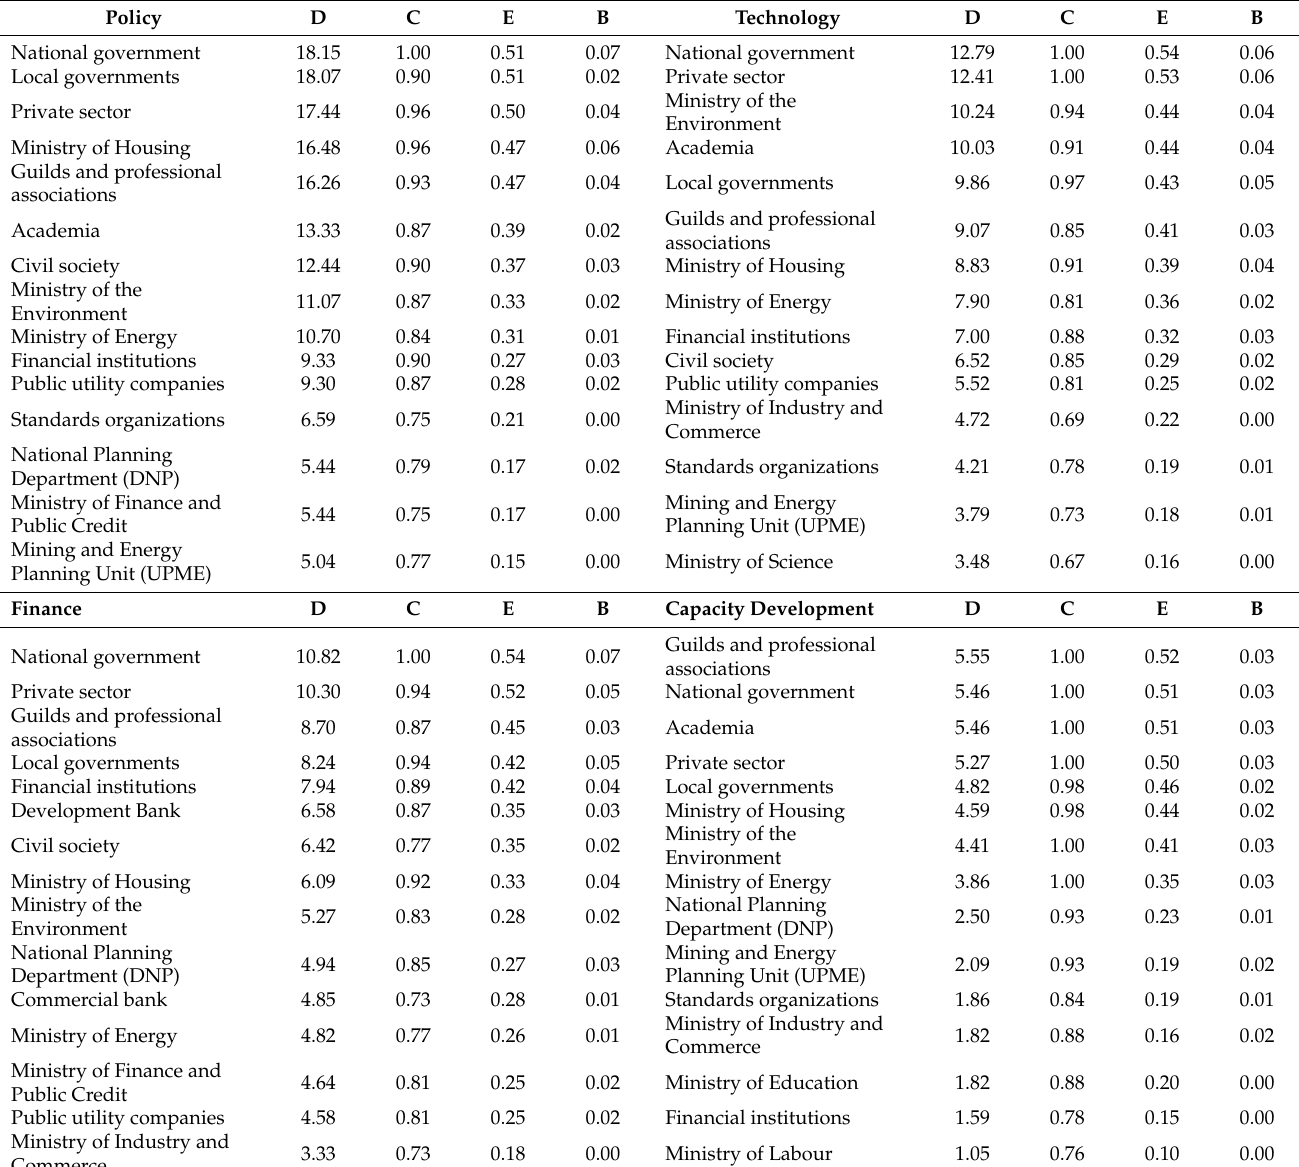
Table 7. Network-based metrics per